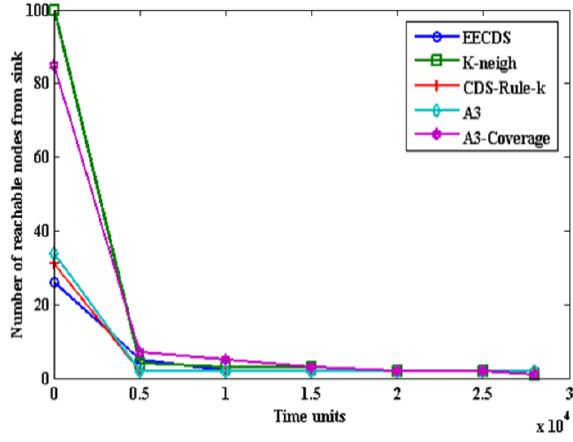
Figure 8 . Network lifetime for number of reachable nodes from